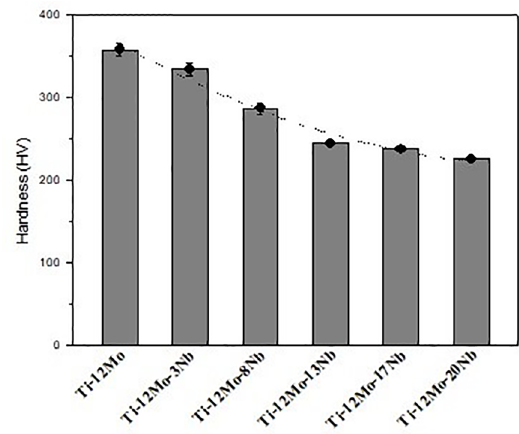
Figure 3. Variation of hardness in according with increase the niobium content in the as–cast Ti-12Mo-xNb alloys. The same effect was corroborated by Borborema et al. 13,23,25 and Kin et al. 26 reporting that niobium acts as a β-stabilizer and in controlled cooling other phases are not formed (eg ω phase) and hardness decreases as a result of increasing niobium content.